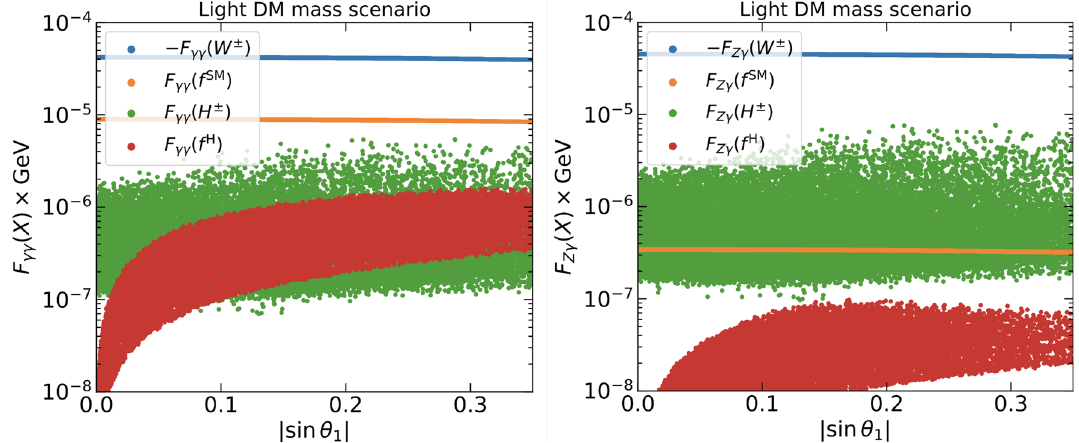
Fig. 15 Same as Fig. 14 but for the light DM mass